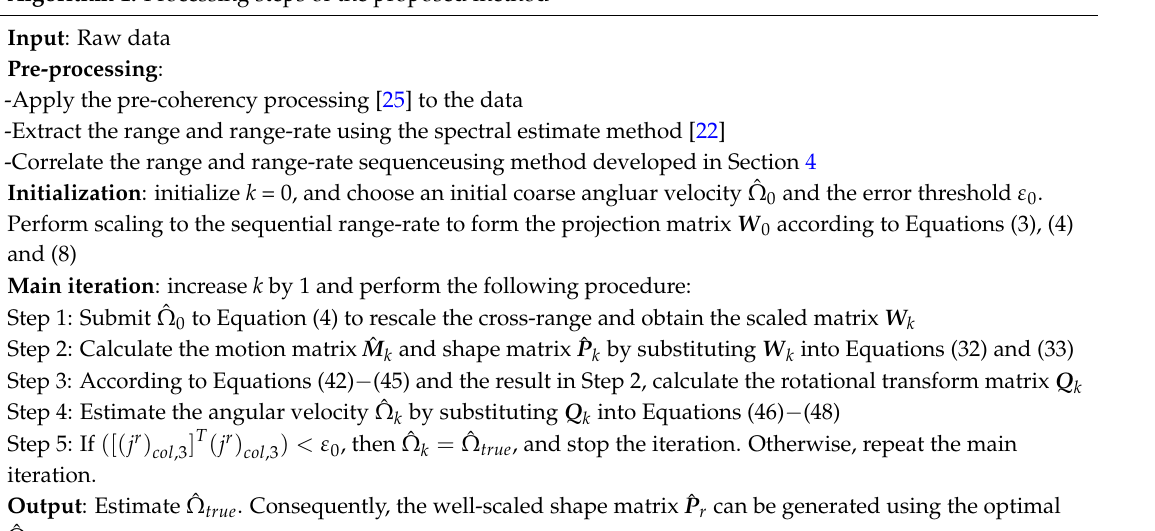
Algorithm 1: Processing steps of the proposed method